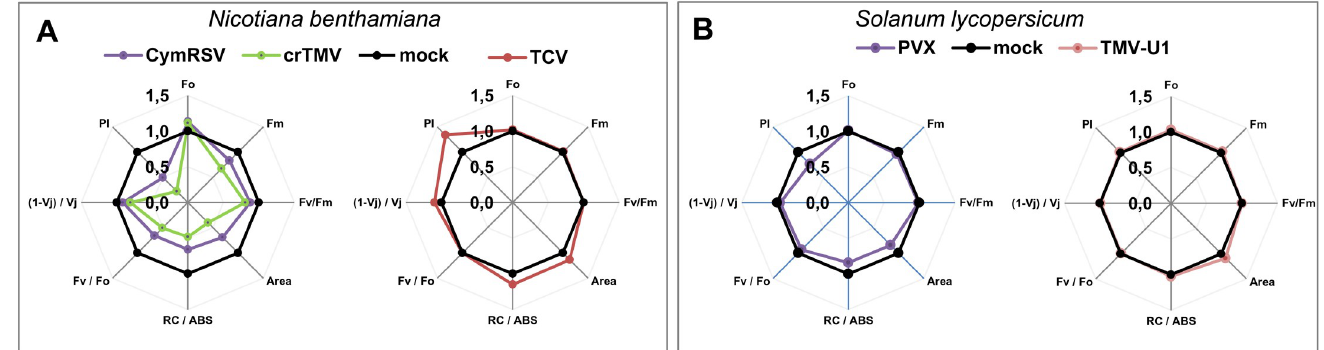
Fig 8. Chlorophyll fluorescence in virus-infected N . benthamiana and S . lycopersicum plants. Spider graphs show calculated chlorophyll fluorescence parameters of (A) N . benthamiana infected with CymRSV, crTMV (7 dpi) and TCV (11 dpi) and (B) S . lycopersicum infected with PVX and TMV (8 dpi). Parameters shown are initial (Fo) and maximal (Fm) fluorescence levels; the Fv/Fm and Fv/Fo (maximal PSII quantum yield) ratios; the area parameter, the dissipated energy flux per active reaction centre (RC/ABS); the (1-Vj)/ Vj parameter, where Vj = (F2ms–Fo)/Fv; and the performance index (PI) measured on the third/fourth young fully developed branches from the apical tip. The data refer to virus-infected plants (colour symbols) after normalization with respect to values obtained in the mock- inoculated plants (black symbols). Data are means of 3 independent biological plant replicates per treatment.